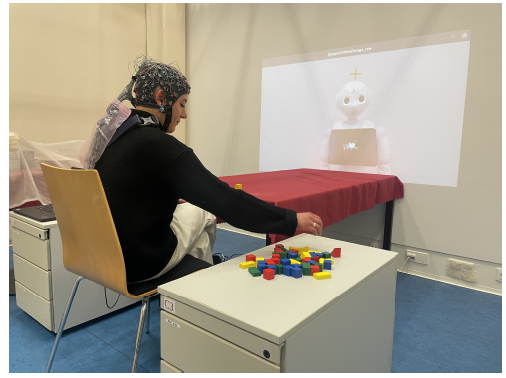
Figure 3. Setup from the CSL